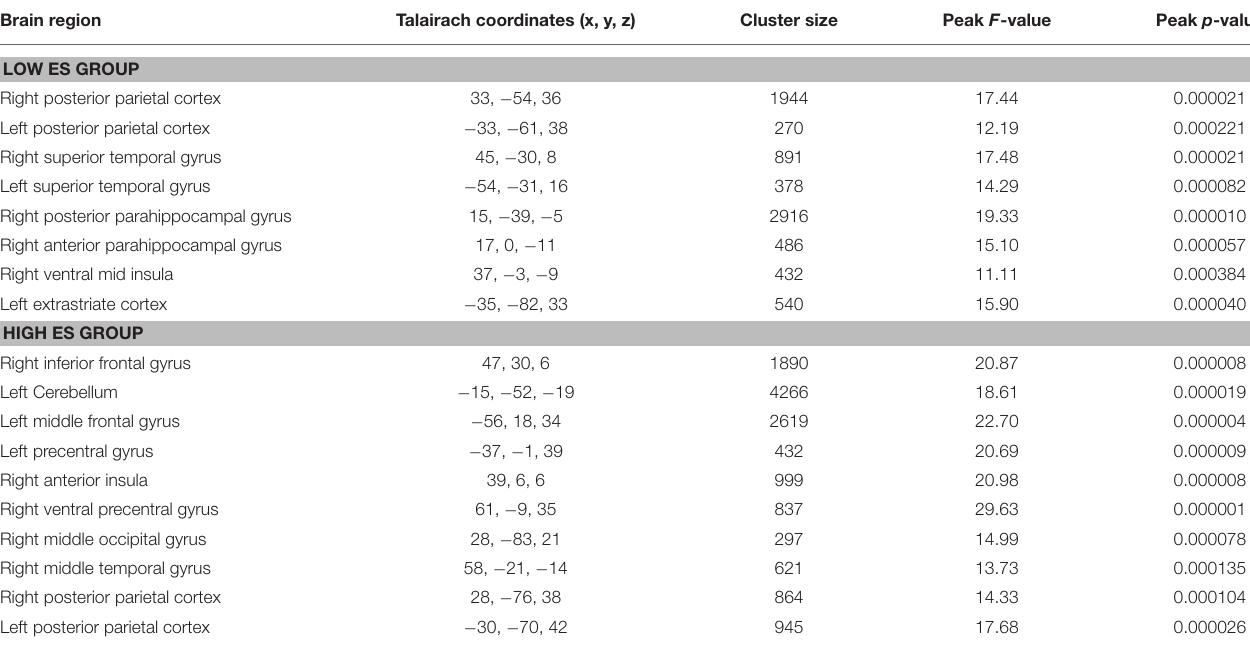
TABLE 3 | Anatomical and statistical details regarding modulation of neural activity by experimental condition (i.e., differentiating between neutral, pleasant, unpleasant stimuli) in flavor processing in the low and high ES group. Brain